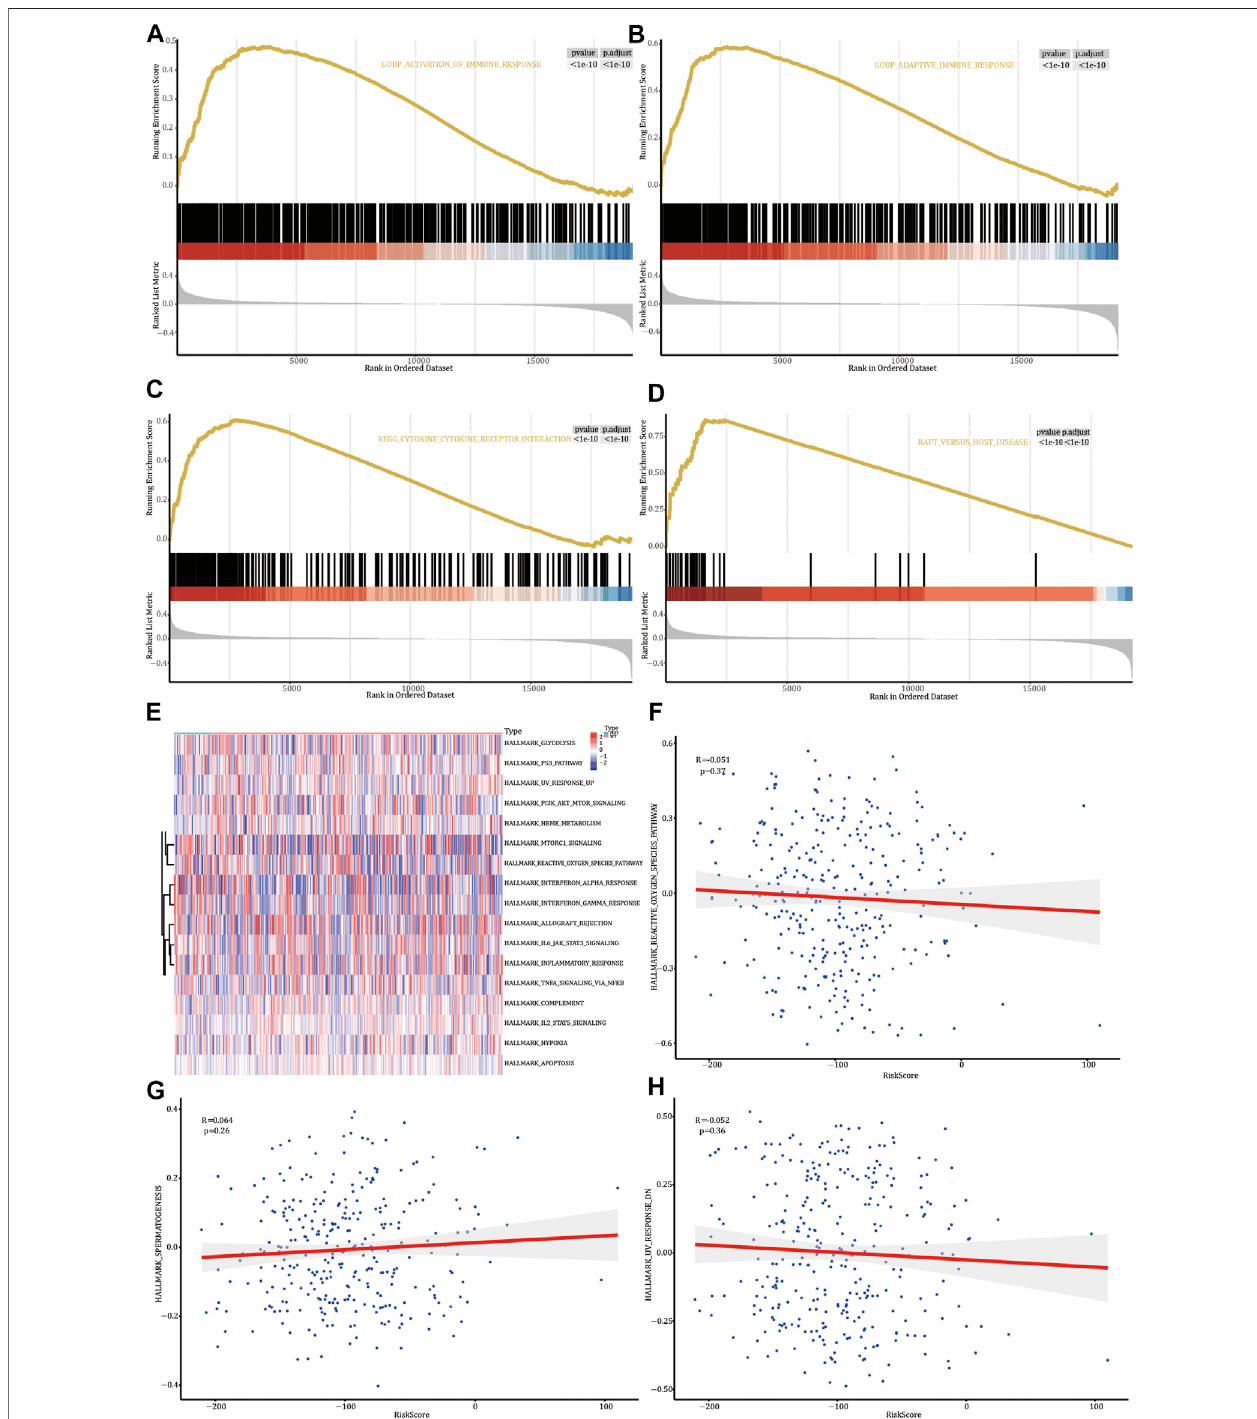
FIGURE 7 | Gene Set Enrichment Analysis (GSEA) and Gene Set Variation Analysis (GSVA). GSEA biological function enrichment analysis shows activation of the immune response (A) and adaptive immune response (B). GSEA biological pathway enrichment analysis results show cytokine-cytokine receptor interaction (C) and adaptive immune response (D) . (E) Heat map of signi fi cant hallmarks analyzed using GSVA. Scatter plot of correlation between signi fi cant hallmark and risk score: reactive_oxygen_species_pathway (F) , spermatogenesis (G) , and uv_response_dn (H) .